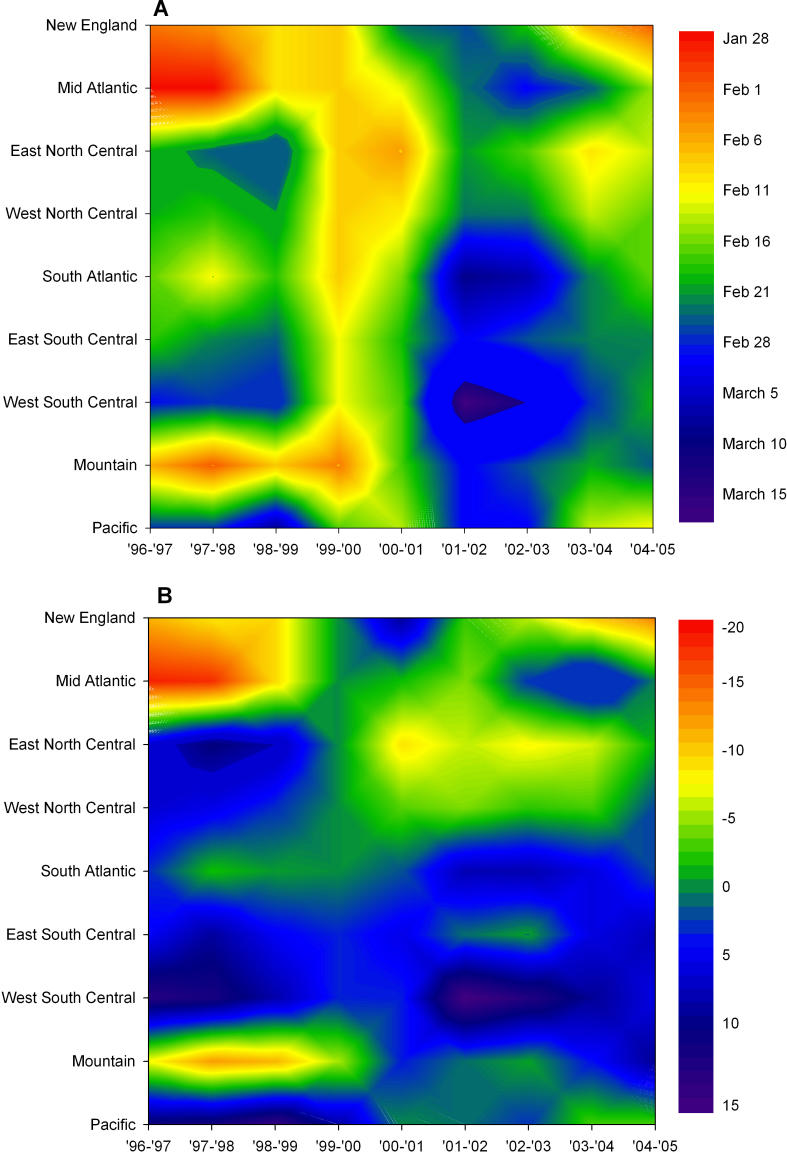
Timing of Influenza Illness across the Nine Major Geographic Regions of the United States (1996–2005)For each influenza year, phase shifts are calculated as the maximum value from cross-correlation of the band-pass filtered weekly P&I mortality data.(A) Contour plot of raw phase shifts between regions for each season, which displays shifts in the absolute timing of influenza mortality peaks from year to year. The plot shows the shifts in the yearly phase, with the 1999–2000 season exhibiting an overall earlier peak and the 2001–2002 season (following September 11, 2001) exhibiting an overall later peak across all regions.(B) Contour plot of demeaned phase shifts, which displays typical regional patterns and relative time to transnational spread. For each season, demeaned phase shifts were calculated by subtracting the mean peak date. The plot reveals increased variation in phase shifts (time to transnational spread) during the earliest influenza seasons, 1996–1997 and 1997–1998, as well as the increased variation during the 2001–2002 influenza season.